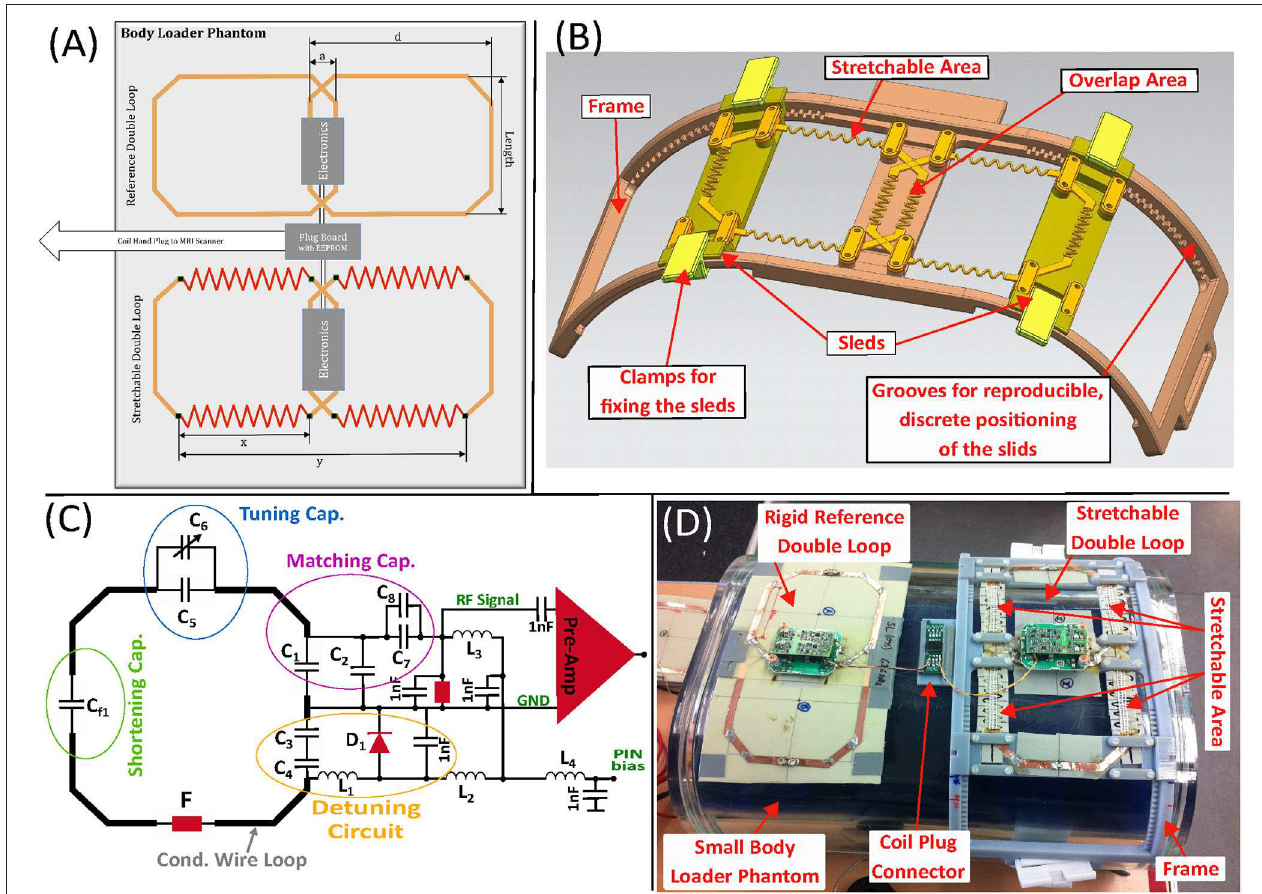
FIGURE 1 | (A) Schematic of the used test-setup for material measurements. The setup allows reproducible testing of different conductive materials used for an adaptive double-loop configuration that can be enlarged/stretched and immediately compared to a rigid reference double-loop. (B) Two rectangular loops with a maximum length (z-direction) of 100mm can be attached to the frame (brown) and enlarged in x-direction by shifting the sleds (yellow) in 5mm steps. (C) Simplified RF circuit. (D) Experimental setup with a rigid reference double-loop and a stretchable double-loop mounted on the test-frame, placed on the torso-shaped phantom (see Figure 6) with a main body (blue) filled with per 1,000mL Bayol-oil and 0.011g MACROLEX blue and an outer compartment (clear) filled with per 1,000g H 2 O dist.: 1.25g N iSO 4 x6 H 2 O , 5g NaCl. The coil plug connector in between the two double-loops serves as connector between the test setup and the MRI scanner and houses the coil code. The test-frame is 3D laser-sintered ( StratasysObjetEden 500 V ) using MR-invisible